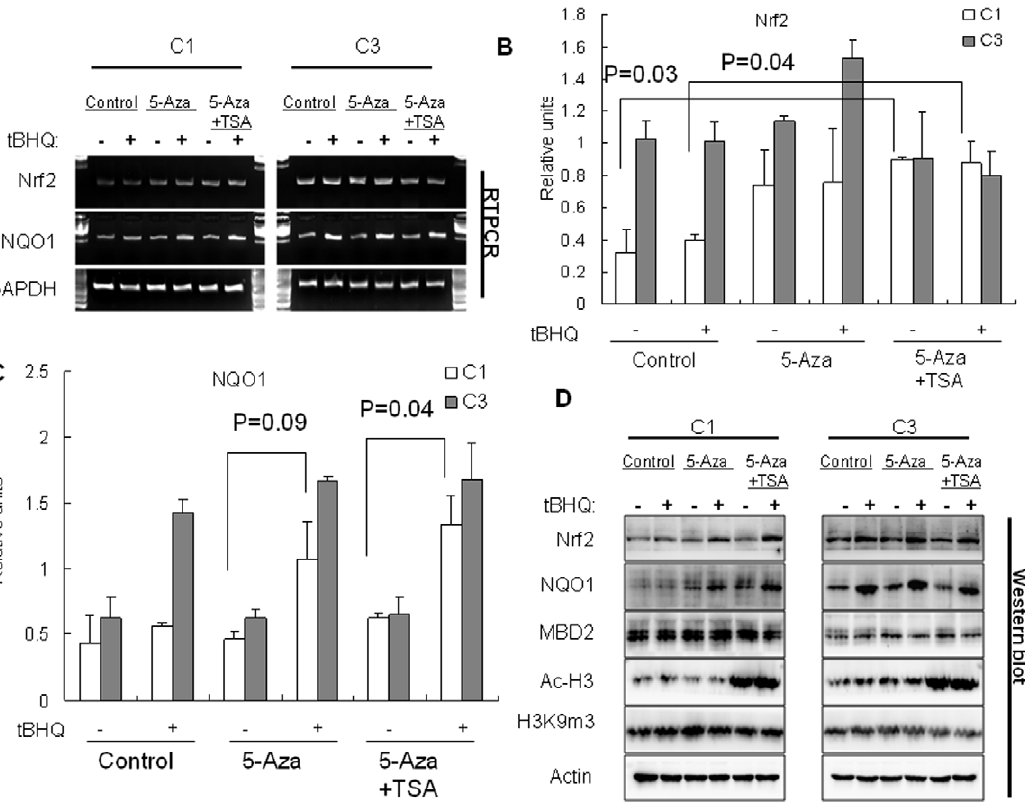
Figure 4. The expression of Nrf2 and NQO-1 in TRAMP cell lines was correlated with CpG islands methylation status and could be restored by 5-aza/TSA treatment. TRAMP C1 and C3 cells were treated with 2 m M 5-aza, 200 nM TSA, or 1 m M 5-aza plus 100 nM TSA for 60 hrs or 48 hrs followed by incubation in the presence of 5 m M tBHQ for further 12 hrs. After treatments, the cells were harvested for total protein or RNA extractions. ( A ) the mRNA levels of Nrf2 and NQO1 were determined by RT-PCR, with GAPDH serving as internal control, and the results from 3 independent experiments were quantified by densitometry and the results are shown in B and C . ( D ) the protein levels of Nrf2, NQO1, MBD2, H3K9me3 and H3Ac were determined by Western blotting, with actin as a loading control. Each experiment was repeated at least twice with similar results.